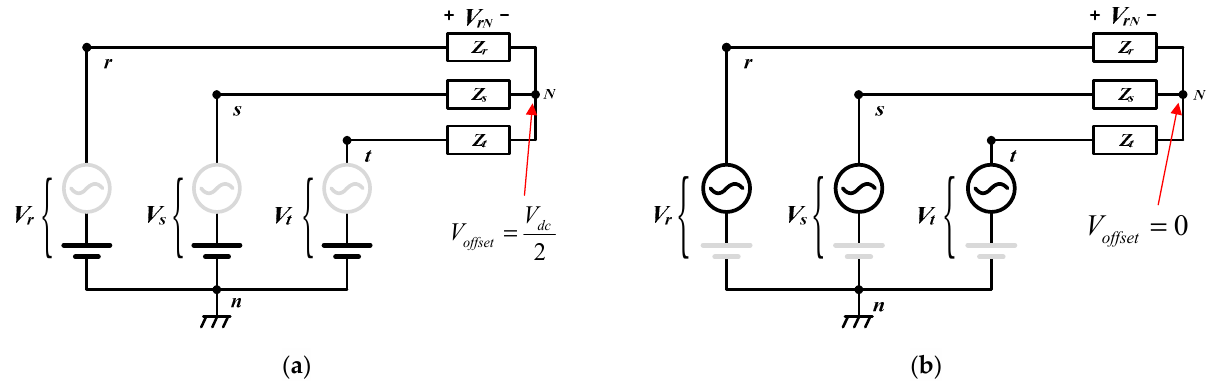
Figure 2. Offset voltage of a 3-leg inverter by the theorem of superposition: ( a ) dc component of the offset voltage; ( b ) ac component of the offset voltage.